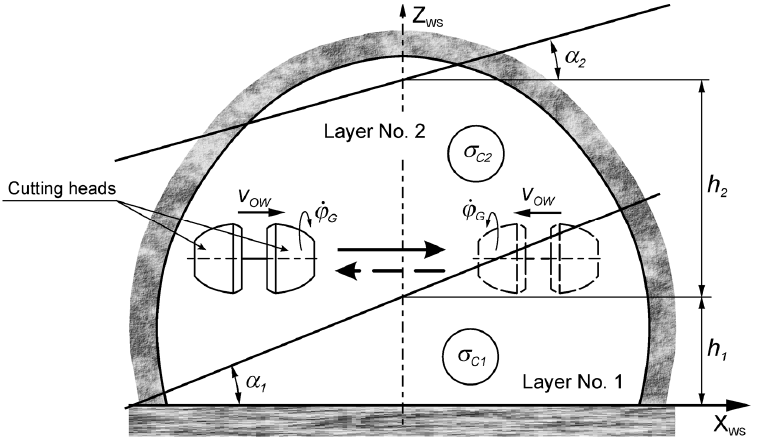
Figure 9. Scheme of mining a rock mass with a layered structure using parallel cuts to the floor of the drilled roadway. drilled